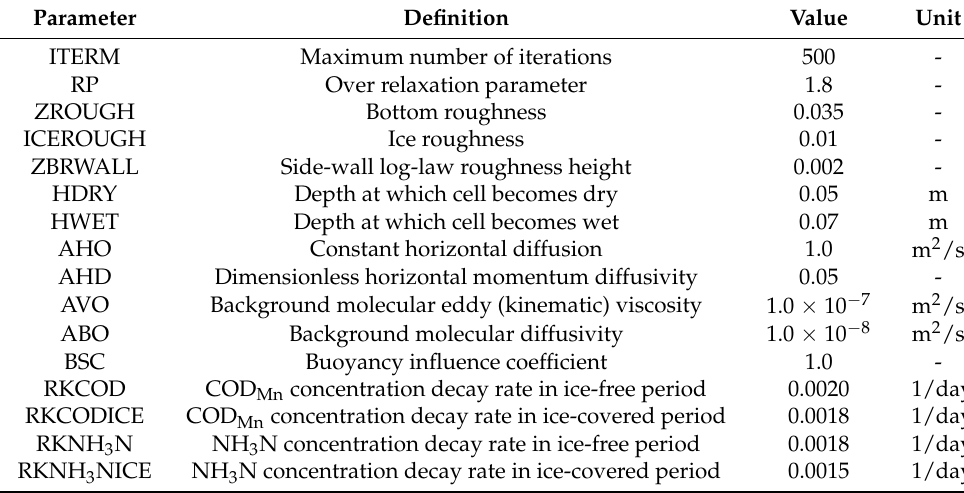
Table 1. Parameter-calibration results of Jingpo Lake model.